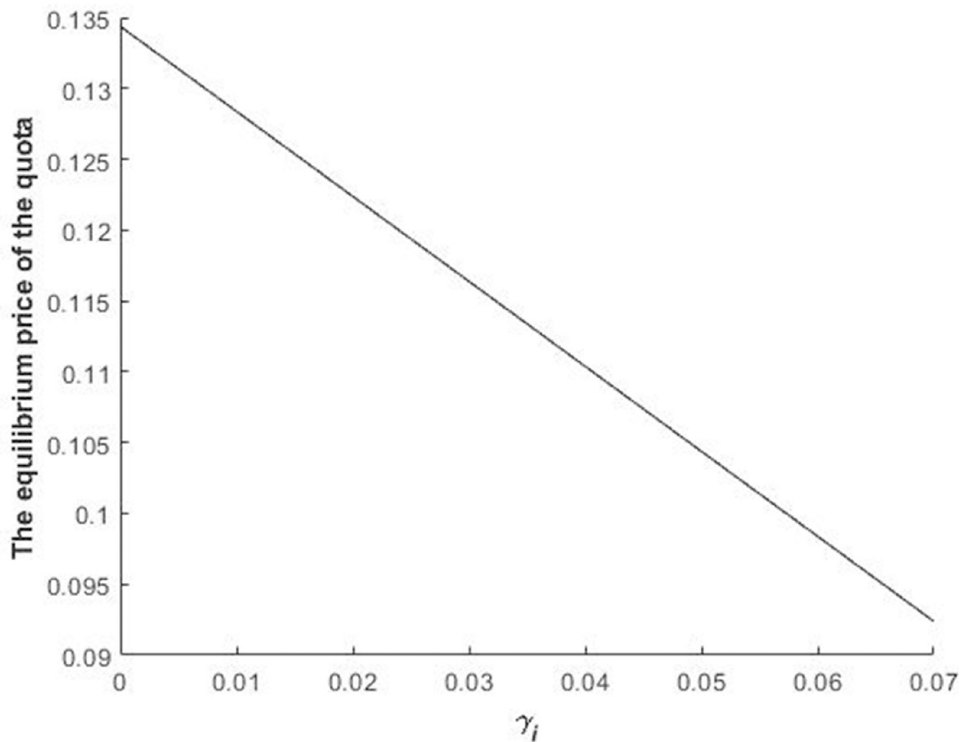
Fig 3. Impact of γ